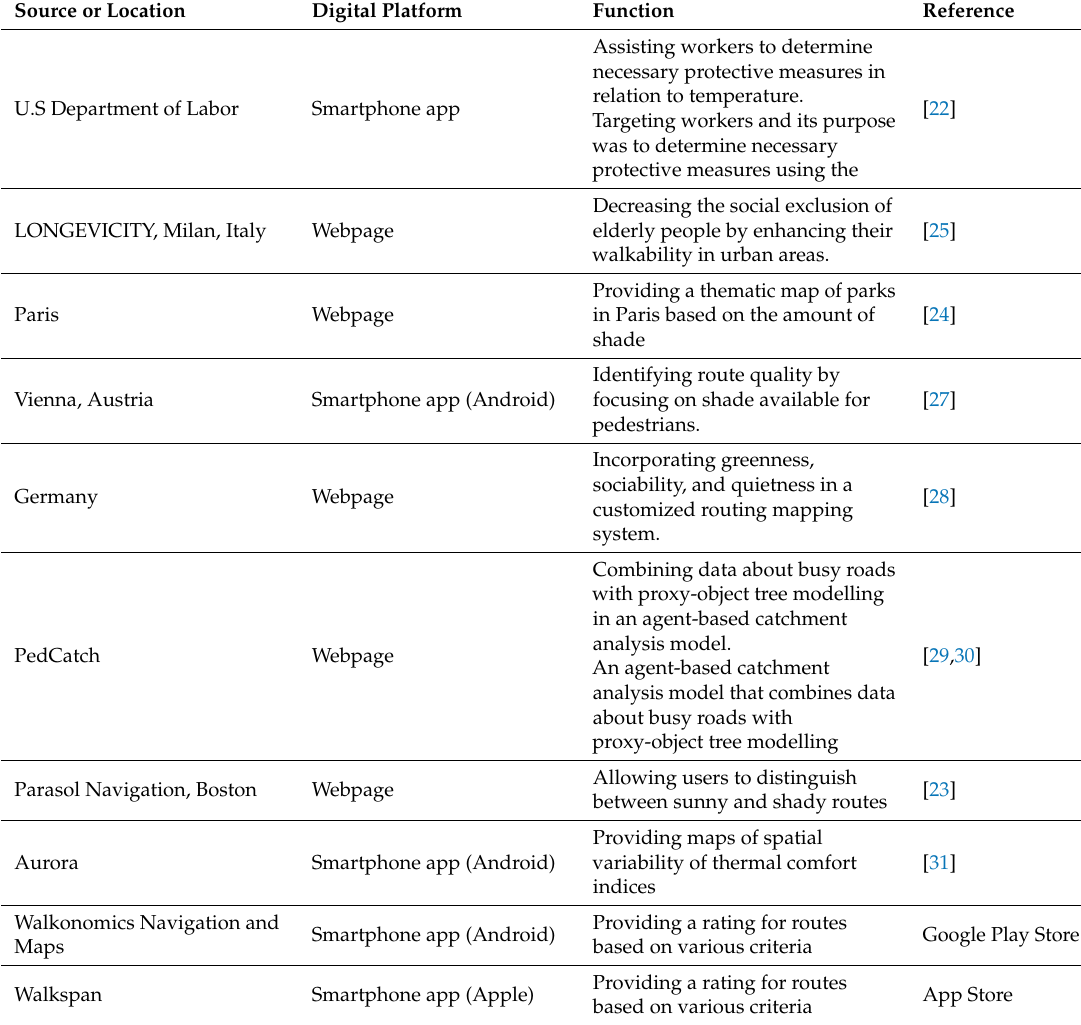
Table 3. Specifications of literature and apps selected for detailed